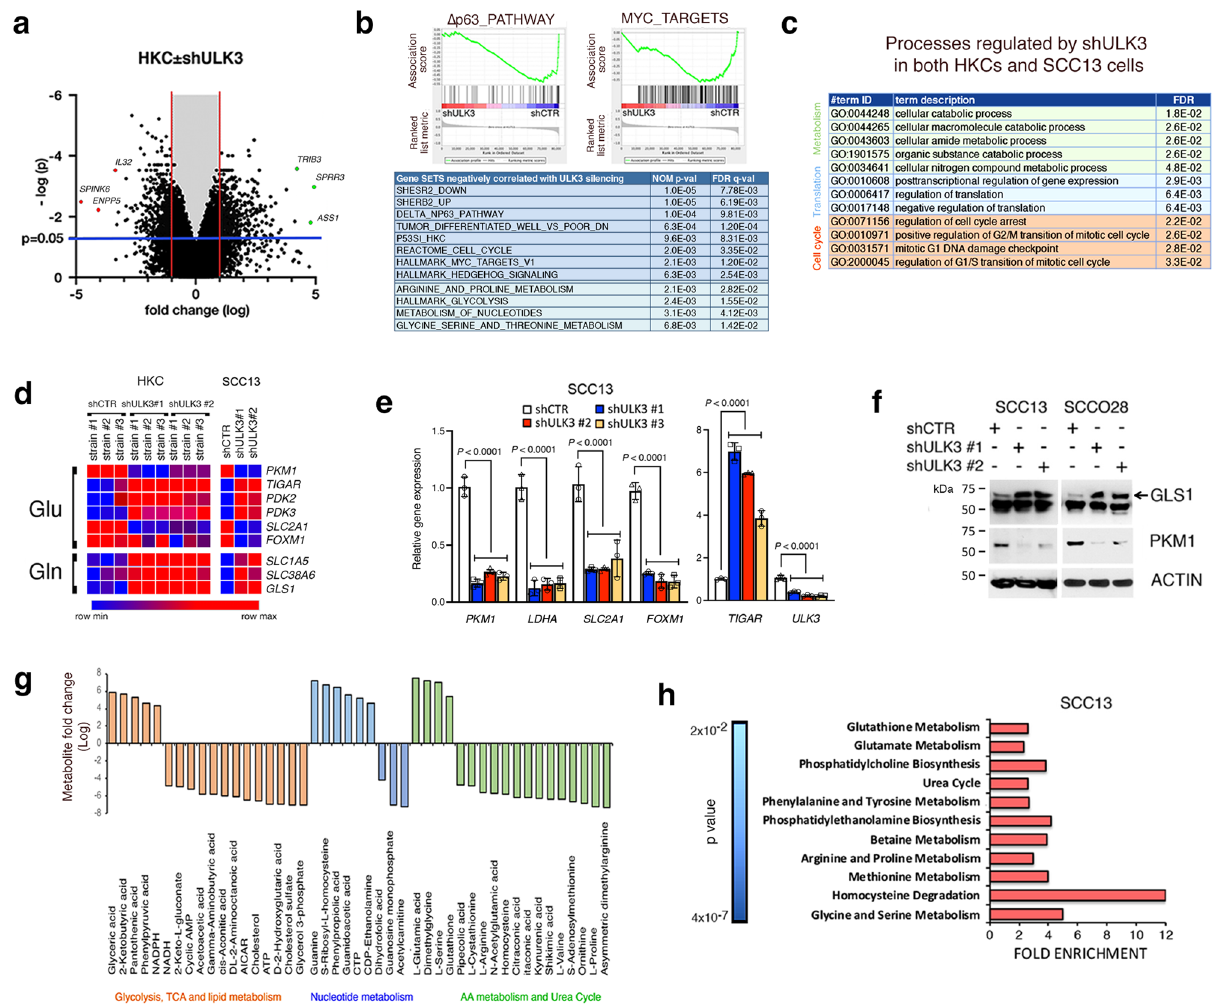
Fig. 4 | ULK3 controls gene expression and cellular metabolism. a Volcano plot of genes regulated inHKCs (strains #TP24,#TP25, #TP31) infected with two ULK3 - silencing versus control lentiviruses (GSE: 183084). Marked are among most downregulated (magenta) and upregulated (green) genes. Clariom D analysis chip was made with Transcriptomic Analysis Console software (TAC) and plotted using Prism. Blue and red lines indicate the threshold of signi fi cance and ±1 fold change respectively, n (HKCs)=3, P =0.05,two-tailed t -test. b Genesetenrichmentanalysis (GSEA) of HKCs pro fi les with ULK3 gene silencing versus control as in (a). Enrich- ment plots of Δ Np63 and MYC -related signatures, and list of most signi fi cant signatures negatively associated with pro fi les of ULK3 -silenced HKCs, divided as related to growth/differentiation (blue) or cellular metabolism (green). n (strains)=3, P <0.001, permutation-based p values. c Gene ontology (GO) analy- sis, by database for annotation, visualization and integrated discovery (DAVID), of the processes consistently regulated by ULK3 silencing in HKCs and SCC13 cells (GSE: 183084 and 183085), divided as pertinent to cell cycle (orange), translation (blue)andmetabolism(green). d Heatmapofexpressionvaluesforcomponentsof